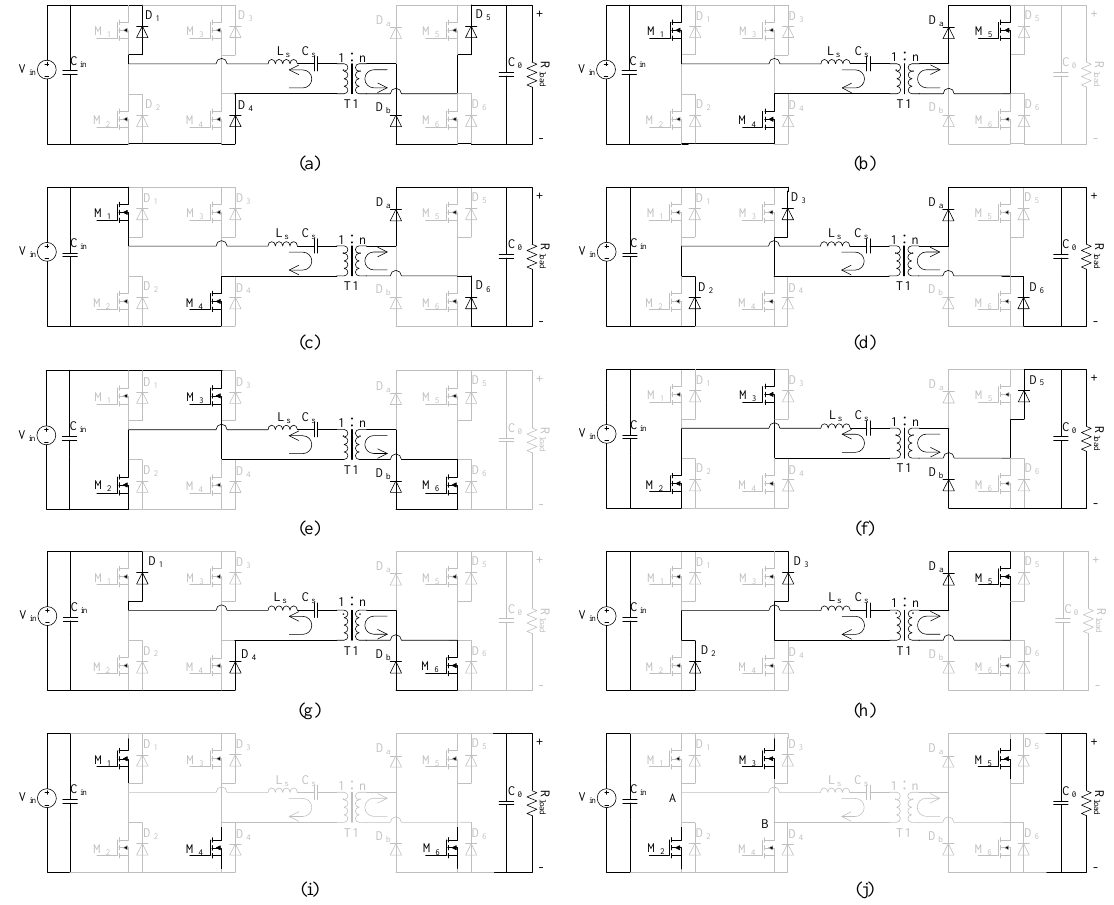
Figure 3. Equivalent circuits during different time intervals in a high-frequency (HF)